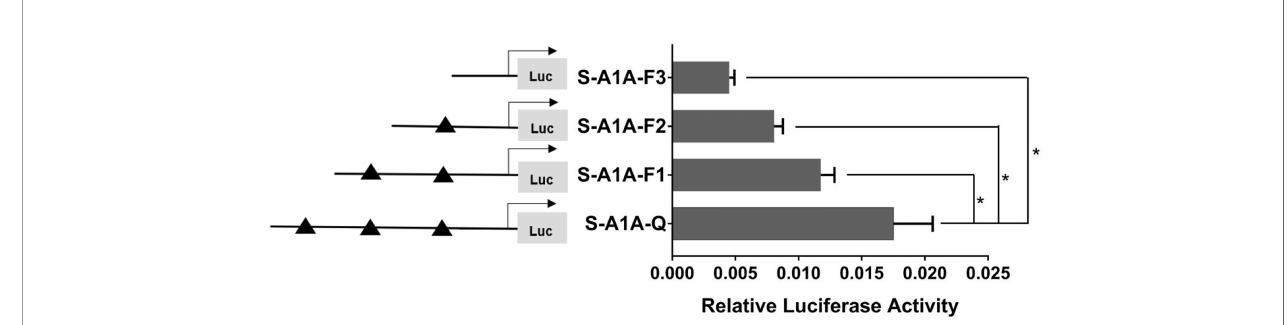
FIGURE 8 | Effect of SF-1 on the transcriptional activity of the cyp19a1a promoter fragment of the progressive deletion site. On the left is a schematic diagram of the promoter deletion and the triangle represents the binding site. The right side is the expression of luciferase in the promoter recombinant vector. S-A1A-F1 (-1291